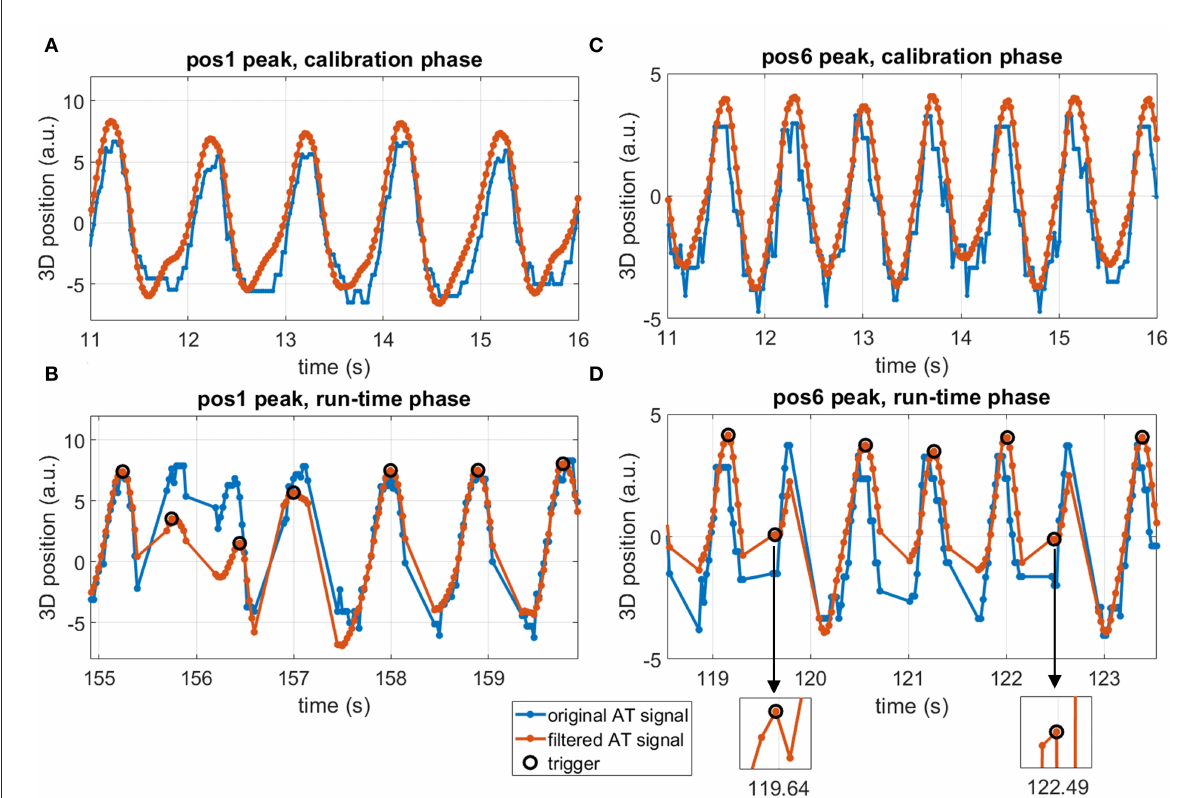
FIGURE6 Active tracking signal segments in two experiments with occasional irregular triggers. (A,B) position #1 with triggering on peak, calibration phase (A) and run-time phase (B) . (C,D) position #6 with triggering on peak, calibration phase (C) and run-time phase (D) . Blue lines: original AT signal, orange lines: filtered AT signal, black circles: detected triggers, pos: position within the LV, a.u.: arbitrary units. Irregular triggers around 156s in (B) correspond to actual signal peaks in both unfiltered and filtered signals, suggesting true physiological variations in heart rhythm. Irregular triggers around 119.5 and 122.5s in (D) correspond to local maxima in the filtered signal, as seen in the zoomed inserts, suggesting an improper trigger description for these cardiac